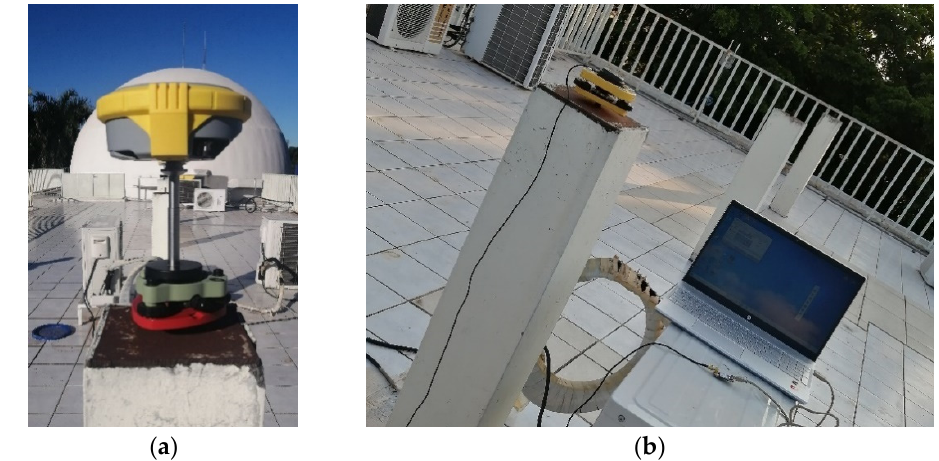
Figure 2. GNSS receivers used: ( a ) geodetic order receiver; ( b ) low-cost GNSS receiver.